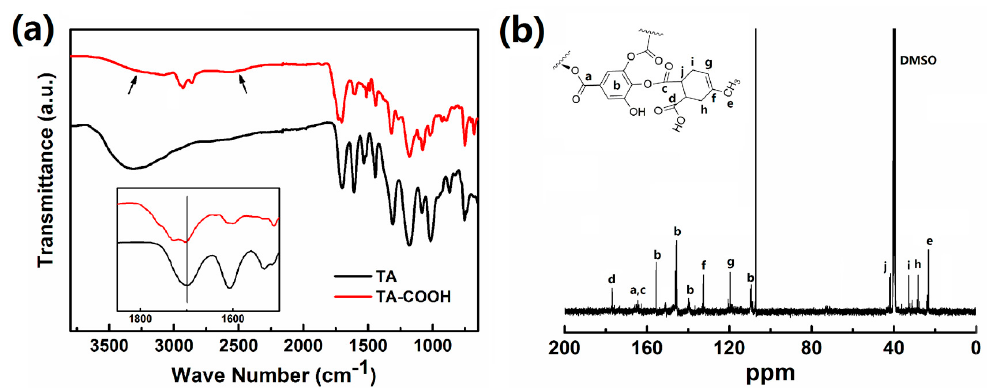
Figure 1. ( a ) FTIR spectra of TA and TA–COOH and ( b ) 13 C-NMR spectrum of TA–COOH.